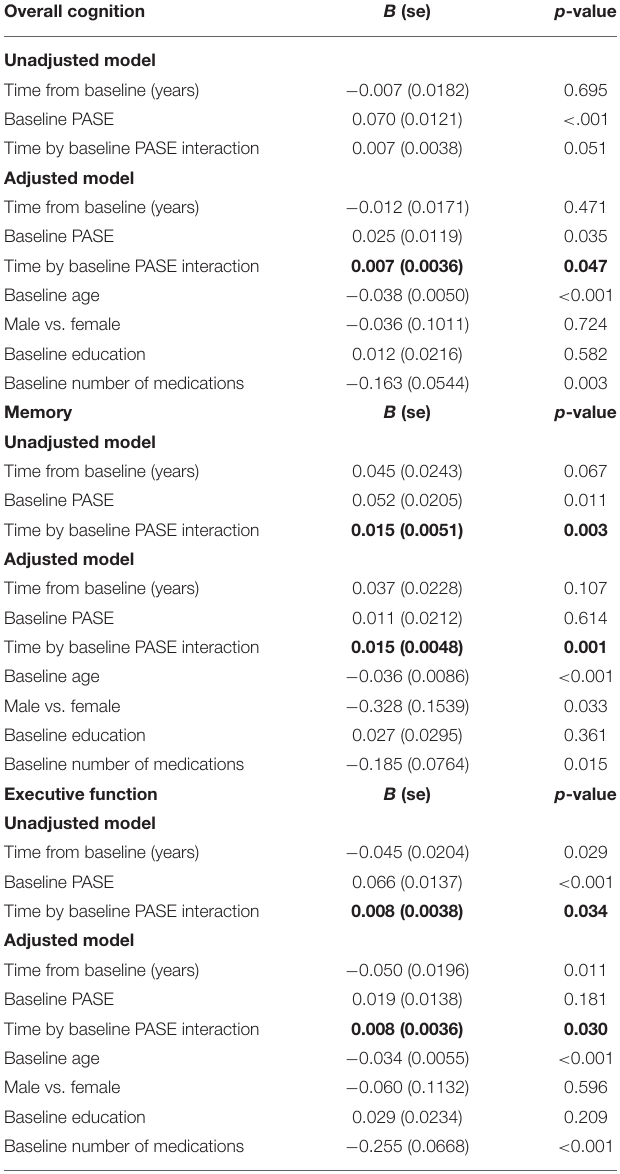
TABLE 3 | Estimated parameters of linear models with interaction with repeated measures for cognitive change over time. Overall cognition B (se) p